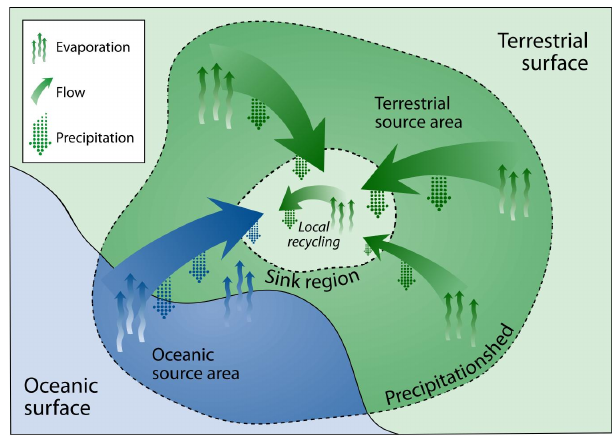
Figure 1. Conceptual precipitationshed; reprinted from Keys et al. (2012), published in Biogeosciences in 2012 (shared under the Cre- ative Commons Attribution 3.0